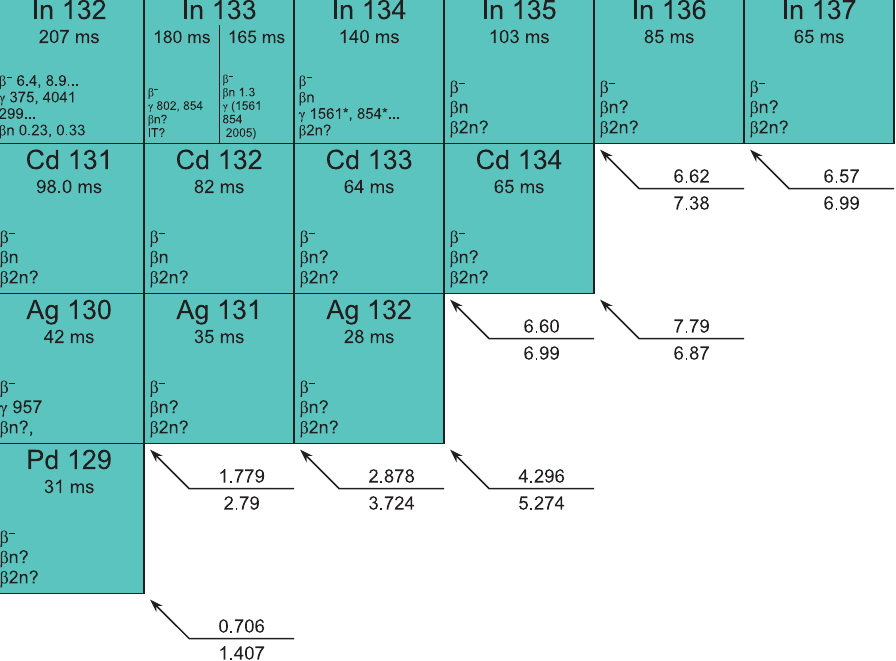
Fig. 8. Mass chain fi ssion yields for masses 129 – 136. The upper and lower values are for thermal fi ssion of U 235 and Pu 239,